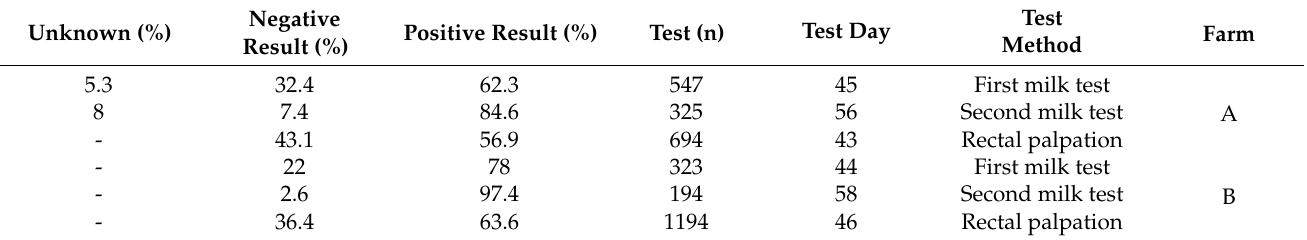
Table 3. Descriptive data on pregnancy results according to test